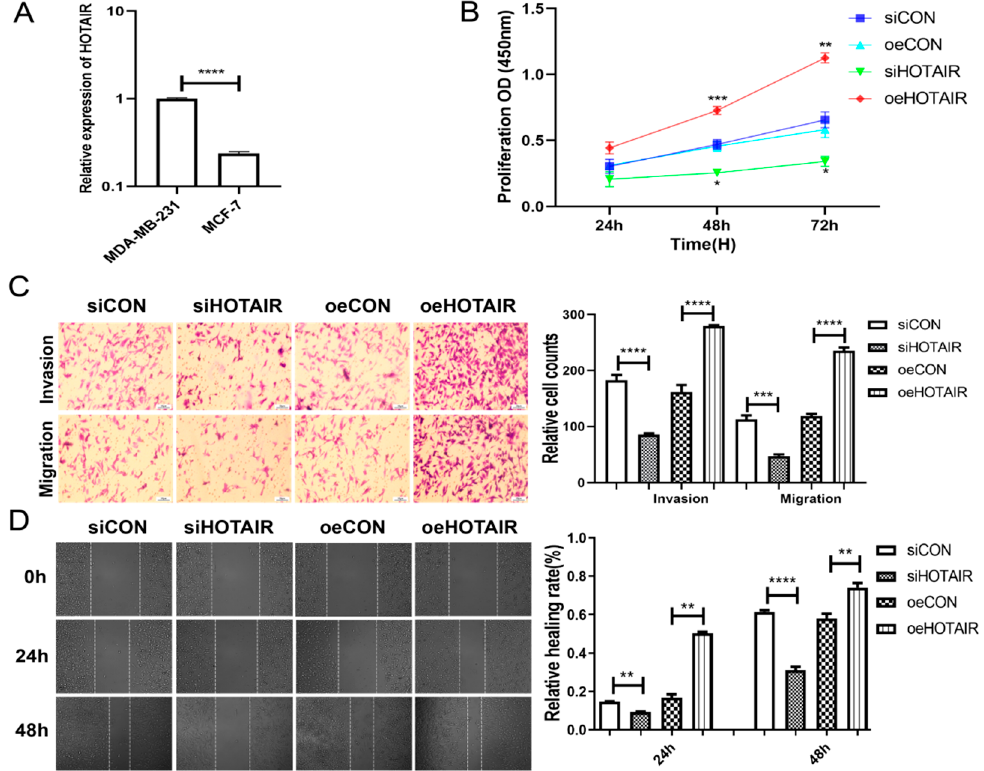
Figure 2. Up-regulation of HOTAIR promotes the proliferation, invasion, and migration of MDA-MB-231 cells. ( A ) RT-qPCR results showed that the expression of HOTAIR was higher in MDA-MB-231 than in MCF-7. ( B ) CCK-8 results showed that the proliferation ability of MDA-MB-231 cells in the si HOTAIR group decreased after 48 h and 72 h compared to the siCON group. Compared with the oeCON group, the proliferation ability of MDA-MB-231 cells in the oe HOTAIR group was increased. ( C ) Transwell assay showed that after 48 h, the invasion and migration number of MDA-MB-231 cells in the HOTAIR overexpression group was significantly higher, while that in the si HOTAIR group was lower than that in the NC group. ( D ) The results of the wound healing assay showed that compared with the NC group, the migration ability of MDA-MB-231 cells in the si HOTAIR group was significantly decreased, and the migration ability of the cells in the overexpression HOTAIR group was significantly higher than that in the NC group. Values were significantly different compared with the corresponding control value at * p < 0.05, ** p < 0.01, *** p < 0.001, **** p <